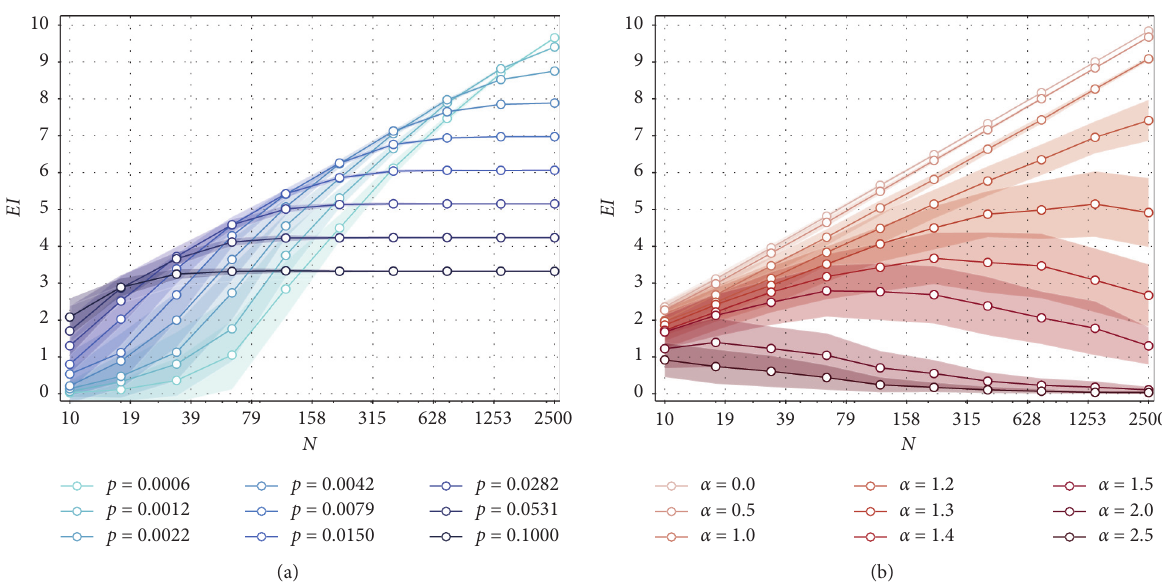
Figure 1: Effective information depends on network structure. (a) In Erdős-R´enyi (ER) networks, we see the network’s EI level off at ( p ) as N , the network’s size, increases (log scale shown). (b) The EI of networks grown under a preferential attachment mechanism, EI � − log 2 which depends on the preferential attachment exponent, α . Under this network growth model, new nodes add their m edges (here, m � 1) to existing nodes in the network with a probability proportional to k α . Only sublinear preferential attachment ( α < 1 . 0 ) allows for the continuous growth of EI with the growth of the network. The ribbons around the data represent standard deviations after 100 simulations of